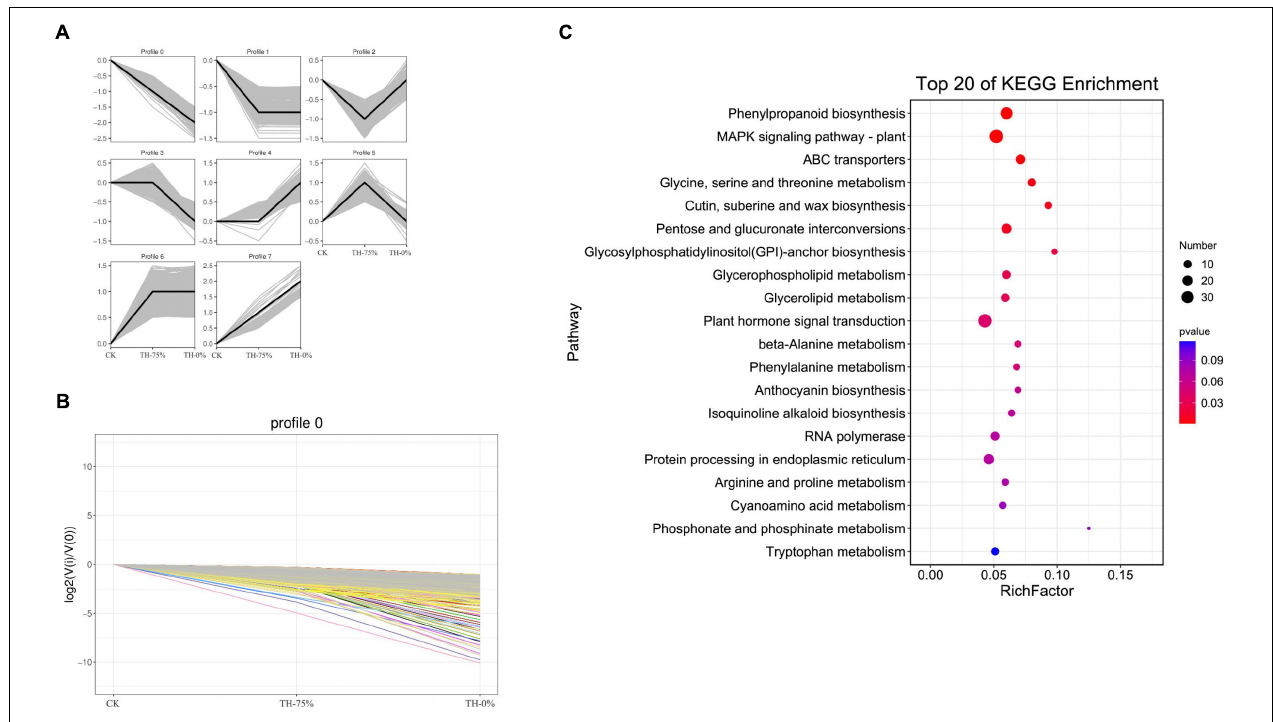
FIGURE 8 | Trend analysis of differentially expressed genes (A) , changes in the gene expression level of profile 0 (B) , and the pathway of genes in profile 0 can be annotated in the KEGG database (C) . From this figure, we can intuitively see the expression changes of genes belonging to this trend, as well as the tightness of aggregation. Each line in the figure represents a gene, and the abscissa is the sample group and the ordinate is the expression change [ log 2 ( V i / V 0 ) ]